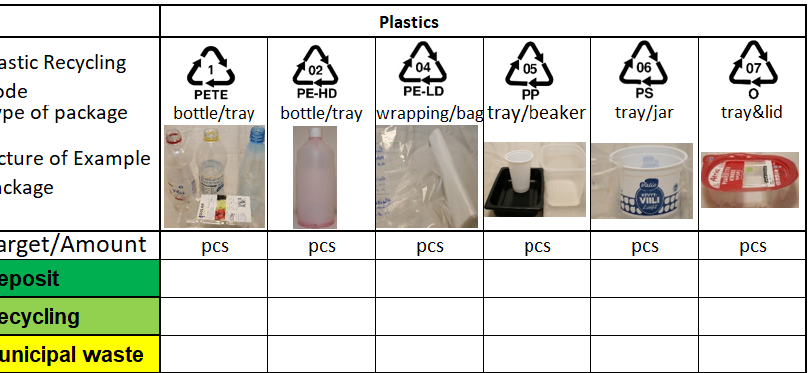
Figure 3. The Excel sheet for reporting plastic food packaging waste. The various packages/materials were divided based on how the packages/materials were recycled, deposited, or placed in munici- pal